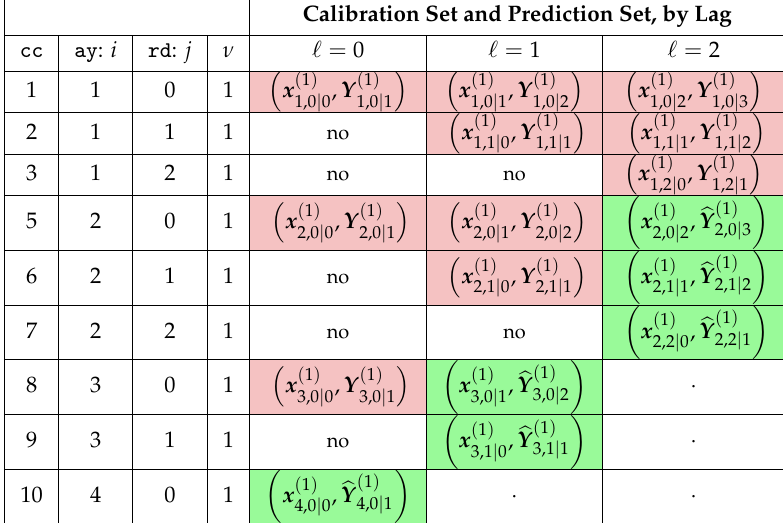
Table 3. Pairs feature-response organized by lag relevant for prediction at time I = 4. Responses on the “last diagonal” (green cells) are not yet observed and require one-year forecasts, which are denoted by (cid:98) Y . In the two remaining “diagonals” neither the responses nor the features are yet observed; two-year and three-year forecasts are required in these cases. Calibration Set and Prediction Set, by